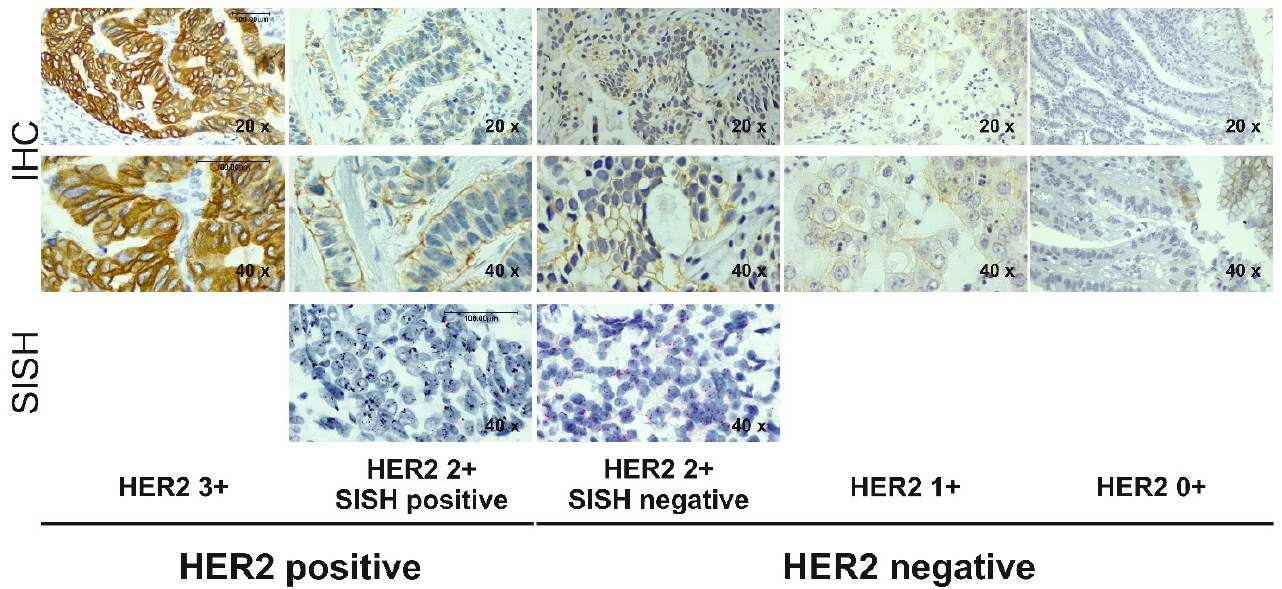
Figure A2. IHC/SISH staining for HER2/ ERBB2 expression/amplification evaluation. Representative images of HER2 3+, HER2 2+, HER2 1+, and HER2 0+ samples showing a progressive reduction in the HER2 expression intensity (brown color; IHC 20 × and 40 × magnification). Pictures of SISH analysis, performed in the equivocal cases (HER2 2+) to discriminate for the presence of tumor cell nuclei with ERBB2 amplification, were also included (black color; SISH 40 × magnification).